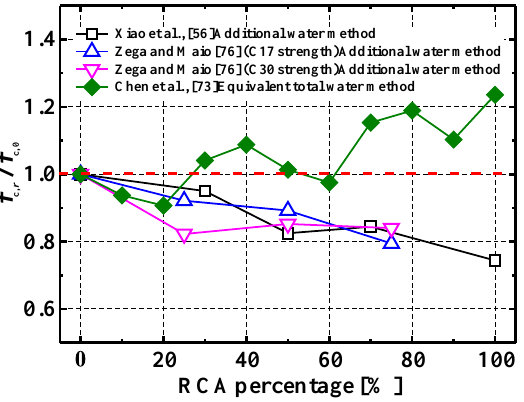
Figure 7. Effect of RCA percentage on 28-day compressive strength of recycled aggregate concrete (RAC) (Note: f c,0 is the cylinder compressive strength when r = 0%; f c,r is the cylinder compressive strength when r ≠ 0%) .